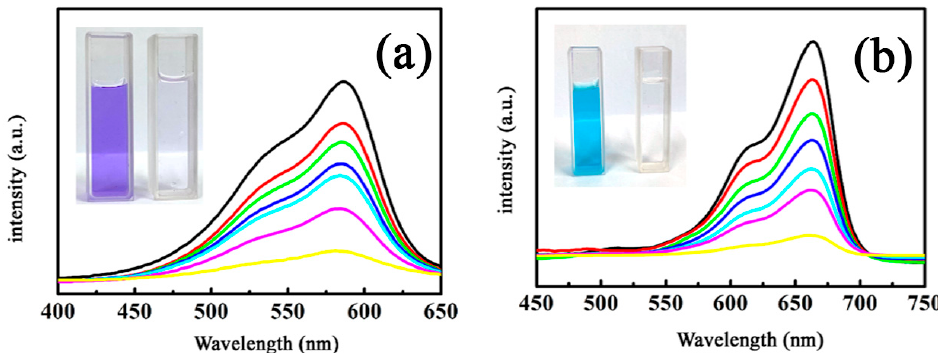
Figure 10. Absorption spectra of ( a ) crystal violet and ( b ) methylene blue solutions in the presence of the MnFe 2 O 4 /BGA composite for the time interval of 15 min; insets are pictures taken at 0 and 90 min, respectively (MnFe 2 O 4 /BGA − 1.3; catalyst dose: 2 mg, volume of 30% H 2 O 2 : 1.0 mL, [dye]: 10 mg/L, volume of dye solution: 50 mL).